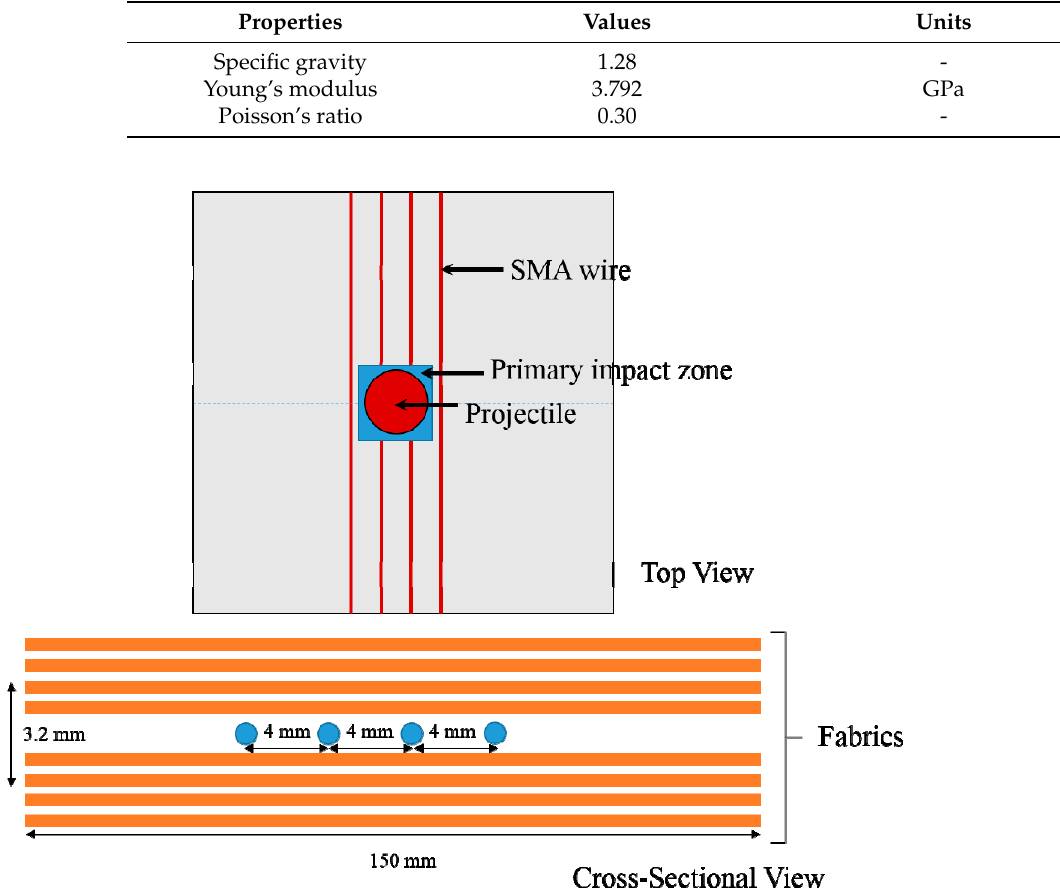
Figure 1. Top view and cross-sectional view of the shape memory alloy (SMA)/glass fiber reinforced composites (GFRP) composite laminates. Table 1. Material properties of pseudo-elastic (PE)-SMA.